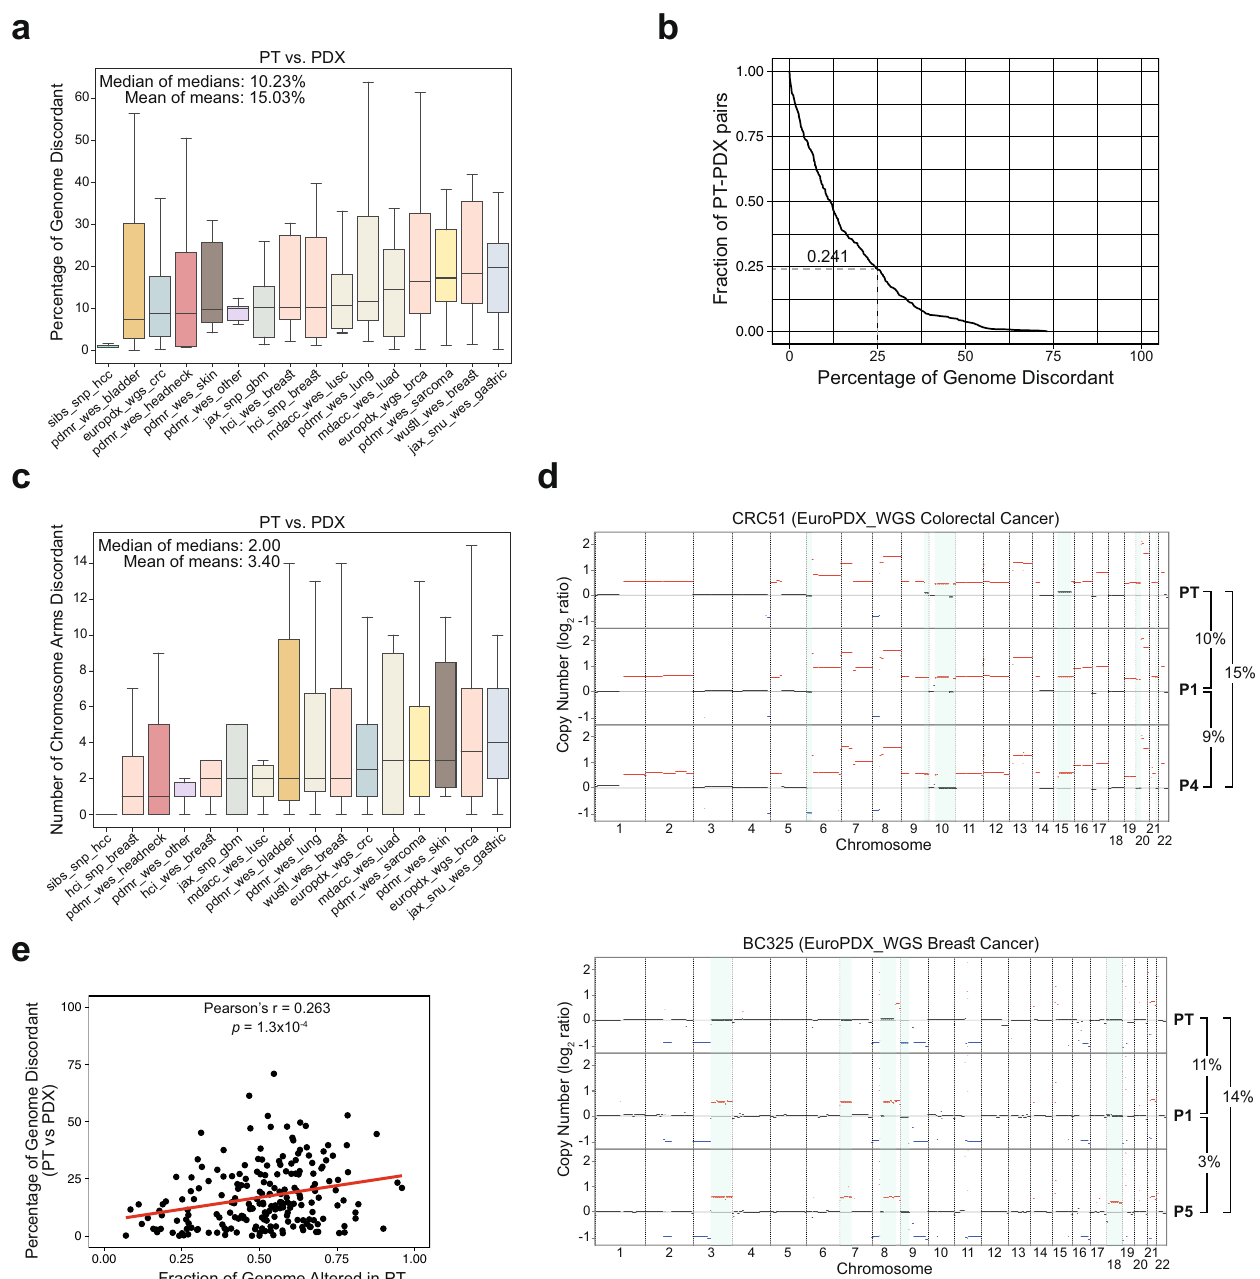
Fig. 1 Thresholds-based comparison of the copy number landscapes of PTs and PDXs. a A cross-cohort comparison of the percent of the genome that is discordant between matched PT-PDX samples. In the median cohort, a median of 10.23% of the genome is altered between PTs and PDXs. Bar, median; colored rectangle, 25th to 75th percentile; whiskers, Q1 – 1.5*IQR to Q3 + 1.5*IQR; outliers were excluded from the plot. b A reverse estimator of cumulative distribution function (1 - eCDF) plot showing the fraction of PT-PDX pairs in which over a given percentage of the genome is discordant. Over 25% of the genome was discordant in 24.1% of the matched PT-PDX samples. c A cross-cohort comparison of the number of chromosome arms that are discordant between matched PT-PDX samples. A median of 2 chromosome arms are altered between PTs and PDXs across cohorts. Bar, median; colored rectangle, 25th to 75th percentile; whiskers, Q1 – 1.5*IQR to Q3 + 1.5*IQR; outliers were excluded from the plot. d Examples of CN differences between matched PT, an earlier-passage (P1) PDX, and later-passage (P4, P5) PDX samples from the EuroPDX_WGS colorectal and breast cancer cohorts. Red, CN gain; blue, CN loss. Prominent differences are highlighted with a light blue background. The fraction of the genome that is altered between samples is shown to the right of the plot. e A scatter plot presenting the correlation between the fraction of the genome affected by CN in the PT and the discordance between that PT and its derived PDX. In general, the more affected by CN a tumor is, the more divergent its PDX is (Pearson ’ s r = 0.26; p = 1.3 × 10 -4